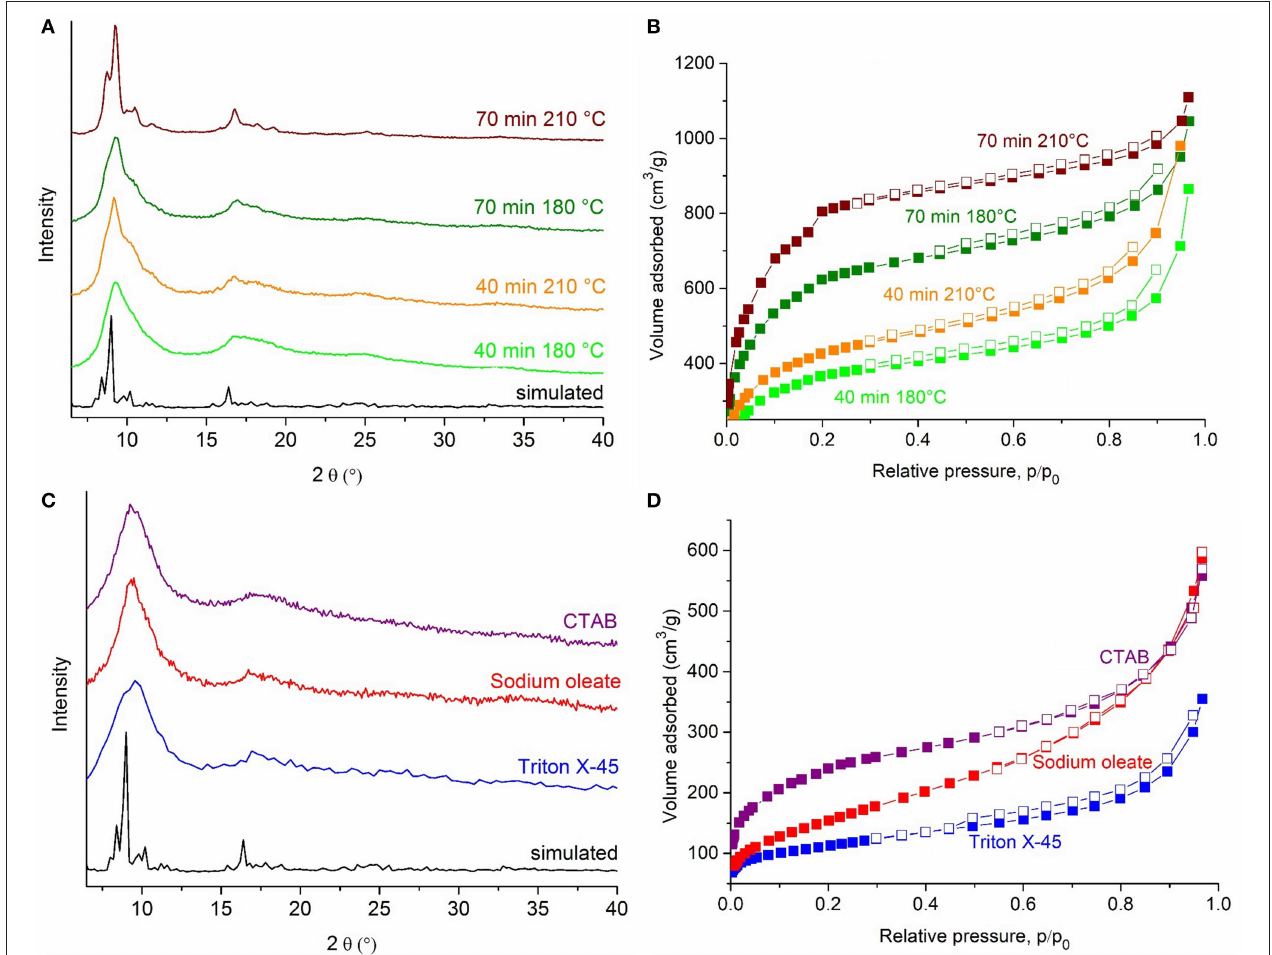
FIGURE 3 | PXRD patterns and N 2 sorption isotherms of nanoMIL-101Cr synthesized in direct emulsion (A,B) for 40min at 180 ◦ C (light green), 40min at 210 ◦ C (orange), 70min at 180 ◦ C (dark green), 70min at 210 ◦ C (brown). PXRD patterns and N 2 sorption isotherms of nanoMIL-101Cr synthesized in reverse emulsions (C,D) by using sodium oleate (red), CTAB (purple), Triton X 45 (blue). Simulated PXRD pattern based on the cif-file of MIL-101Cr, CCDC number: 605510, (black) (Férey et al., 2005). For the N 2 sorption isotherms the samples were activated at 150 ◦ C under vacuum for 12h. Filled symbols depict adsorption, empty symbols